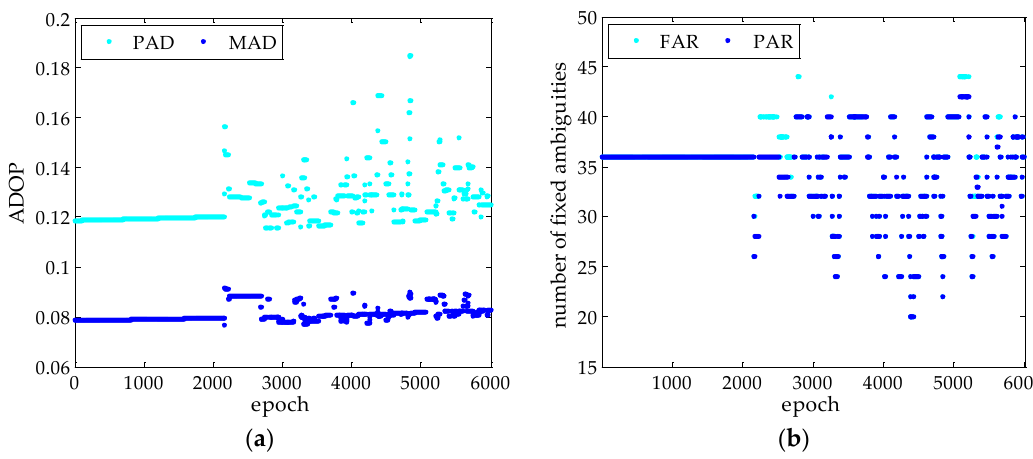
Figure 7. ADOP and fixed ambiguity number for different methods in kinematic experiment: ( a ) is the ADOP for the PAD and MAD methods; and ( b ) is the fixed ambiguity number of the MAD with FAR and PAR.